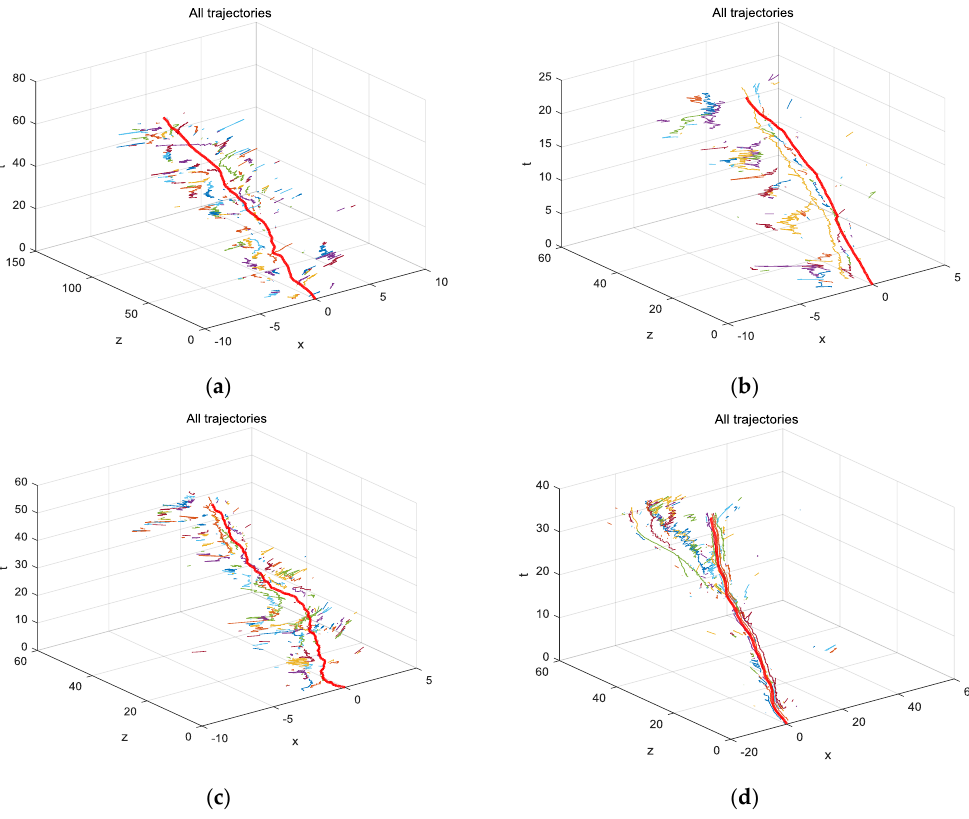
Figure 8. The camera trajectory (long red lines) and targets’ trajectories (short multi-color lines) of four video sequences ( a ) ETH-Bahnhof. ( b ) ETH-Sunnyday. ( c ) MOT16-05. ( d ) MOT16-11.